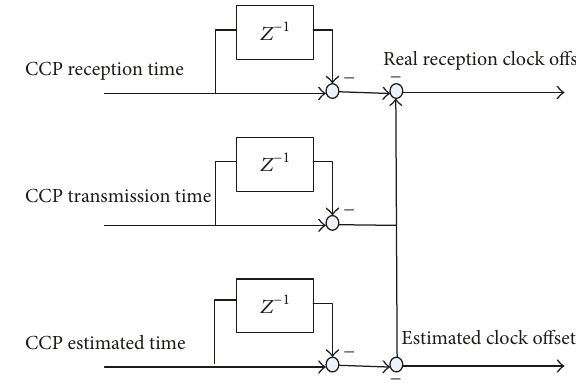
Figure 3: The relative clock variation by clock